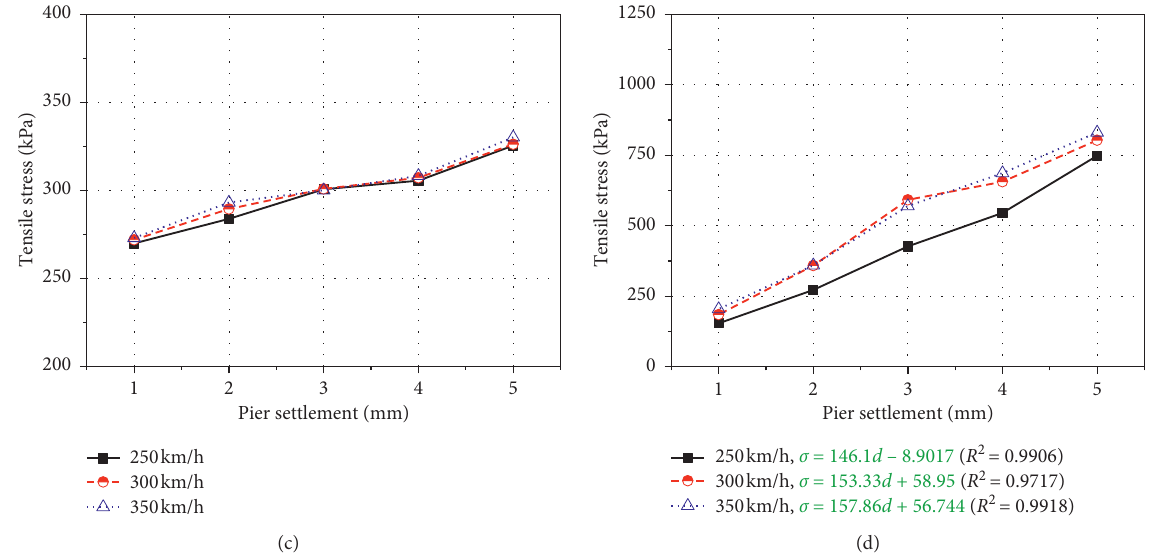
Figure 10: Dynamic tensile stresses of LCTcaused by running train at different speeds: (a) top surface of slab, (b) bottom surface of slab, (c) top surface of base, and (d) bottom surface of